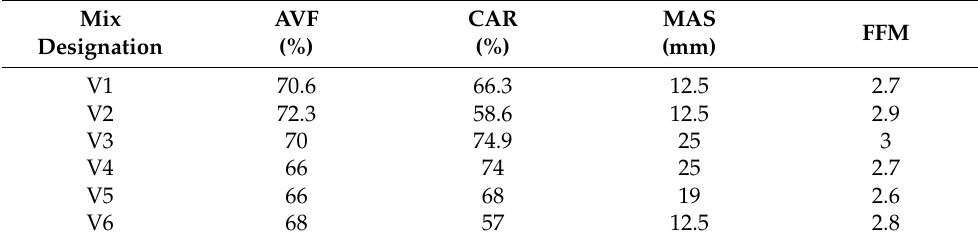
Table 7. Mix proportions of the validation mixes.